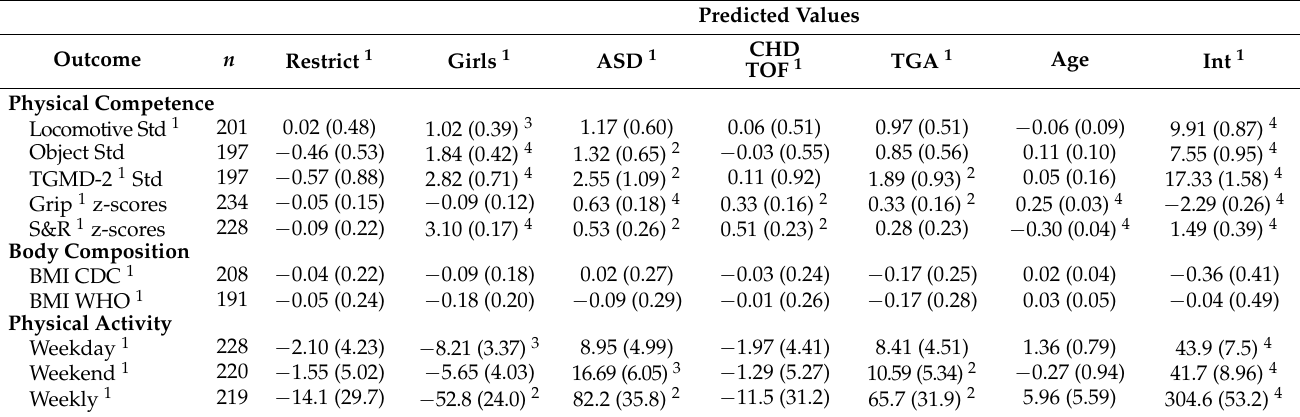
Table 4. Association between health-related fitness and parent-reported restriction of body contact among children with CHD, adjusting for sex, age, and type of